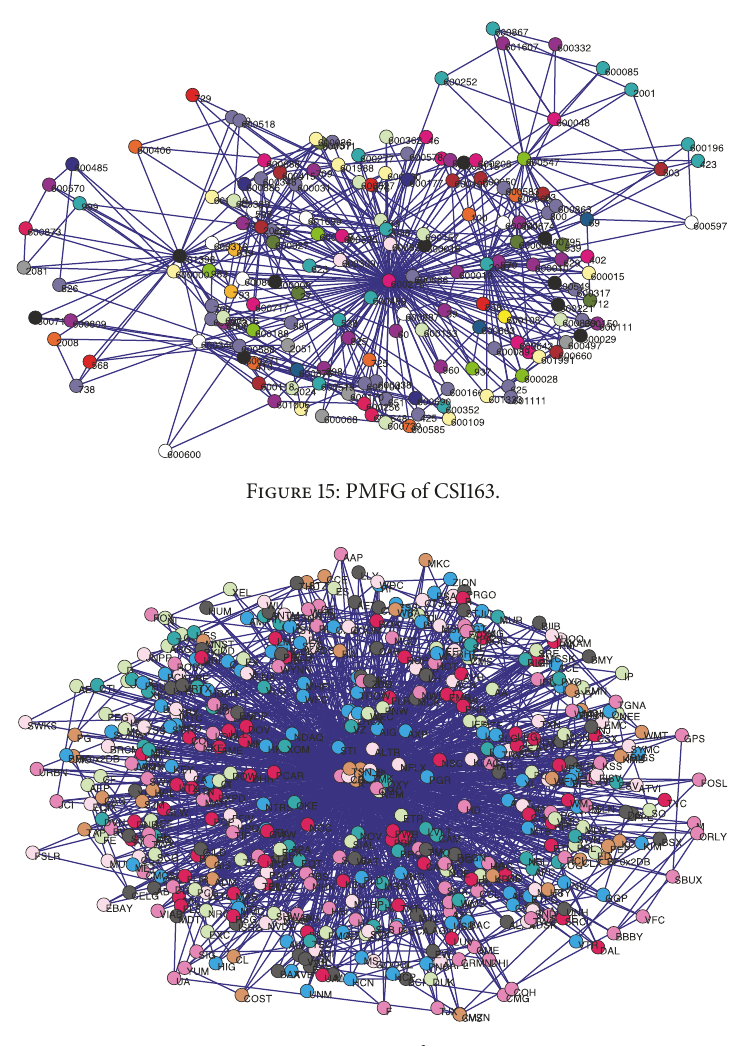
Figure 16: PMFG of